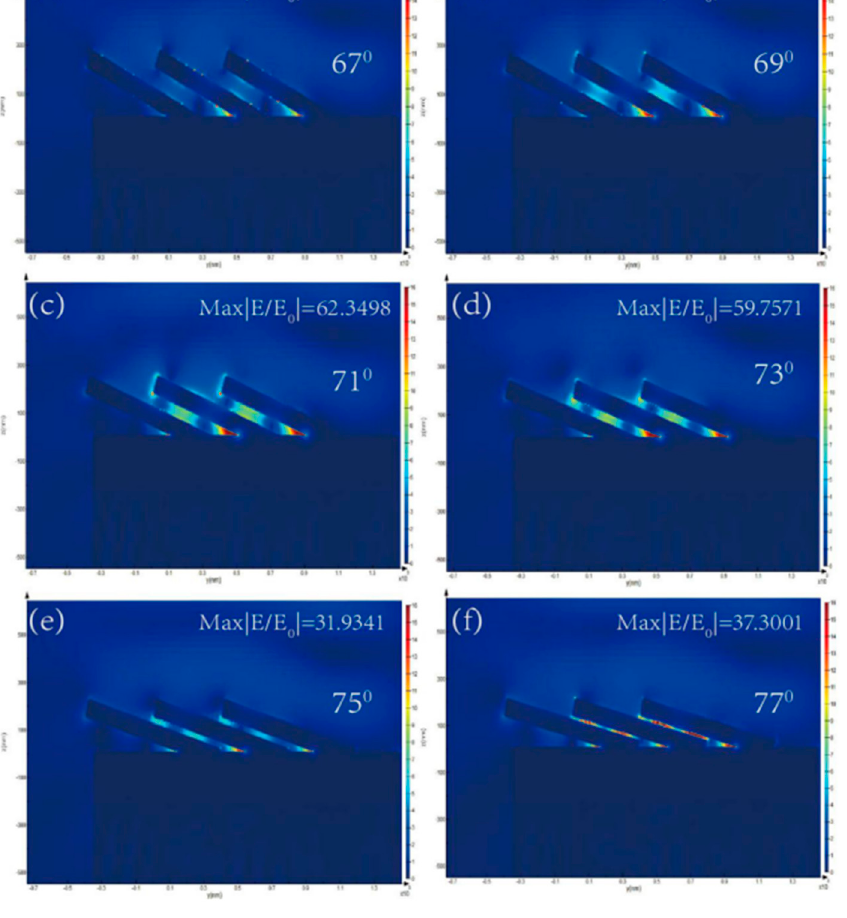
Figure 3. Calculation results of the AuNRs array with different tilting angles by the FDTD method: ( a ) β = 67°; ( b ) β = 69°; ( c ) β = 71°; ( d ) β = 73°; ( e ) β = 75°; ( f ) β = 77°.